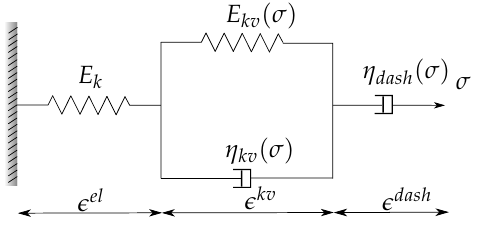
Figure 1. 1D schematic representation of Burgers